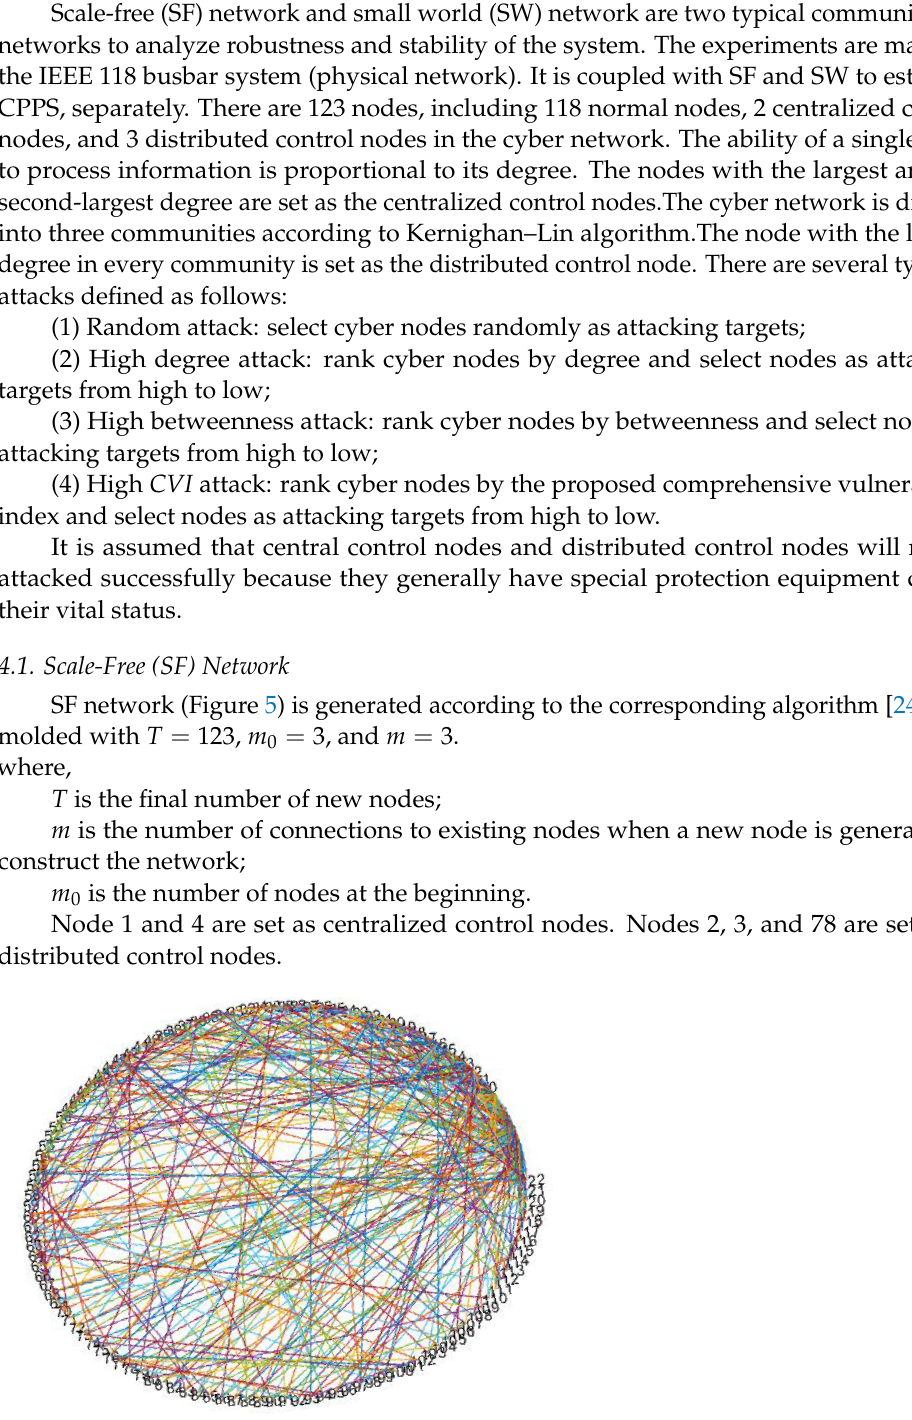
Figure 5. Scale-free